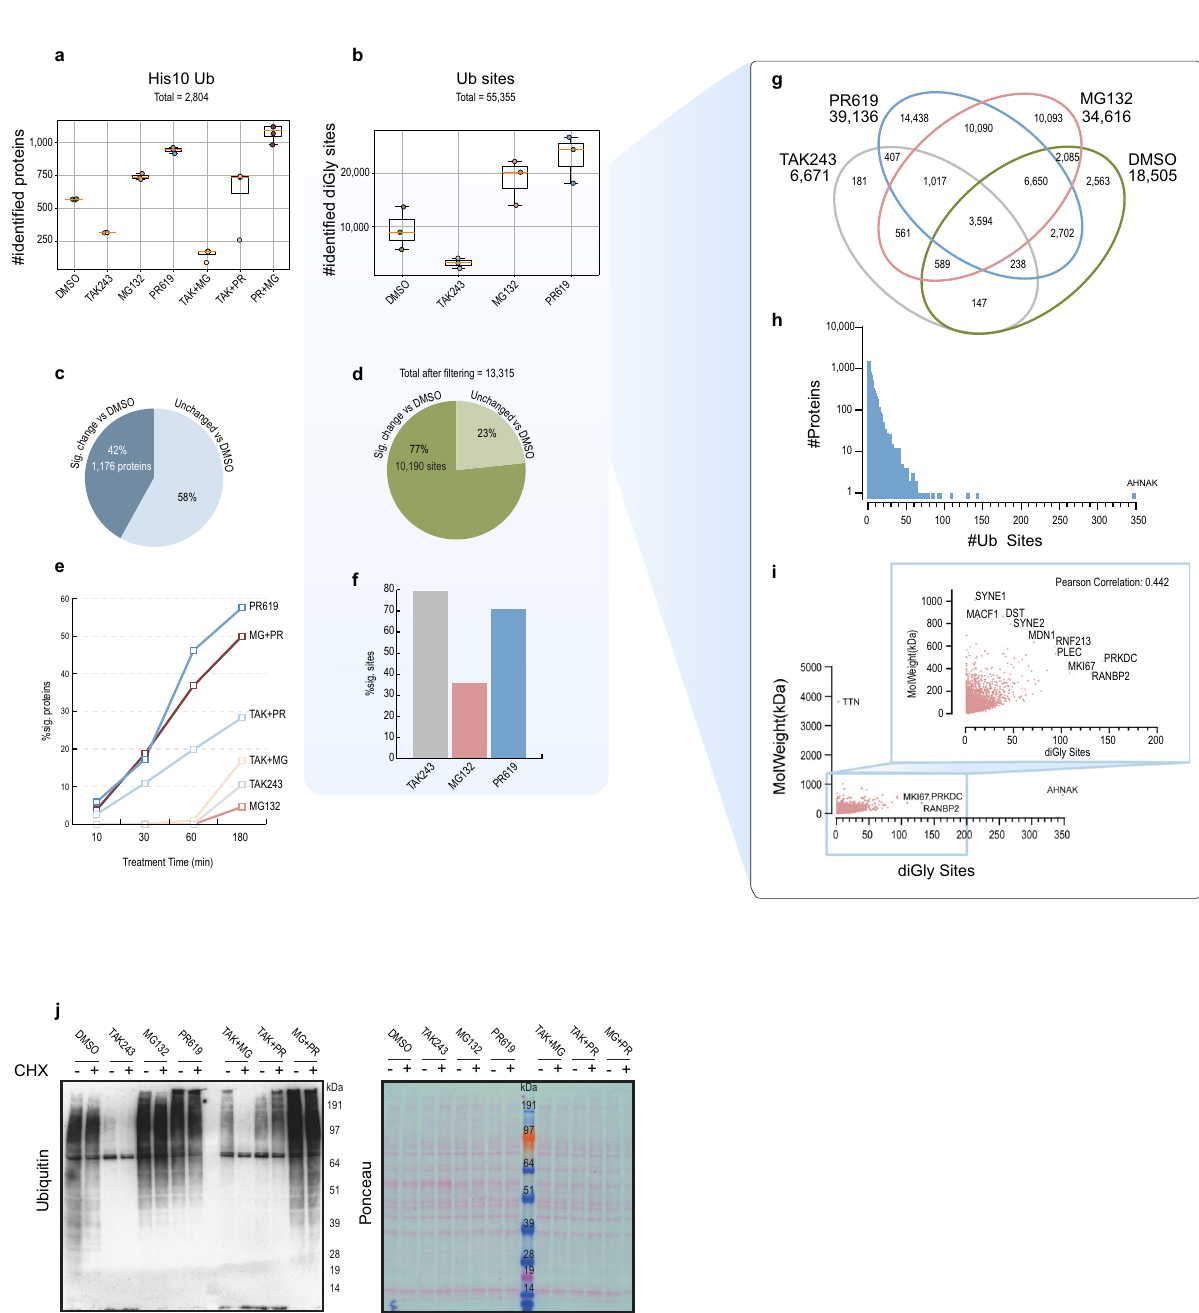
Fig. 2 Identi fi cation of Ub sites and substrates by mass spectrometry. a Identi fi ed His10-Ub substrates puri fi ed from cells treated for 3 h with indicated UPS inhibitors after removing proteins identi fi ed in parental U2OS samples were fi ltered out (all treatments) (right-sided student ’ s t test p value = 0.05, S0 = 0.1), n = 3 biologically independent samples. Each data point is represented by a coloured circle; the box contains the 25 – 75 th percentile and the orange line denotes the mean and the error bars represents the SD. b Identi fi ed Ub sites puri fi ed with UbiSite antibody from U2OS cells treated with the indicated UPS inhibitors for 3 h, n = 3 biologically independent samples. Each data point is represented by a coloured circle, the box contains the 25 – 75 th percentile and the orange line denotes the mean and the error bars represents the SD. c Percentage of proteins in His10-Ub samples that changed signi fi cantly in any of the UPS inhibitor treatments and timepoints in comparison to DMSO control (student ’ s t test FDR = 0.05, S0 = 0.1). d Percentage of Ub sites that changed signi fi cantly in any of the UPS inhibitor treatments in comparison to DMSO control (student ’ s t test FDR = 0.05, S0 = 0.1). e , f Percentage of signi fi cantly altered proteins in response to the indicated treatment at the indicated timepoints in His10-Ub samples ( e ) and Ub sites at 3 h ( f ). g Venn diagram of Ub sites identi fi ed per treatment from UbiSite DDA data, where sites identi fi ed in at least one replicate in multiple treatments were considered as intersections. h Histogram of number of Ub sites identi fi ed per protein. i Scatter plot of number of Ub sites compared to the molecular weight of the protein, with Pearson correlation analysis. j UPS inhibitor treatments, and combinations of UPS inhibitors with or without addition of 50 µ g/ml translation inhibitor Cycloheximide (CHX) at 3 h; samples were immunoblotted for Ub (P4D1), n = 3 biologically independent samples. Source data are provided as a Source Data fi